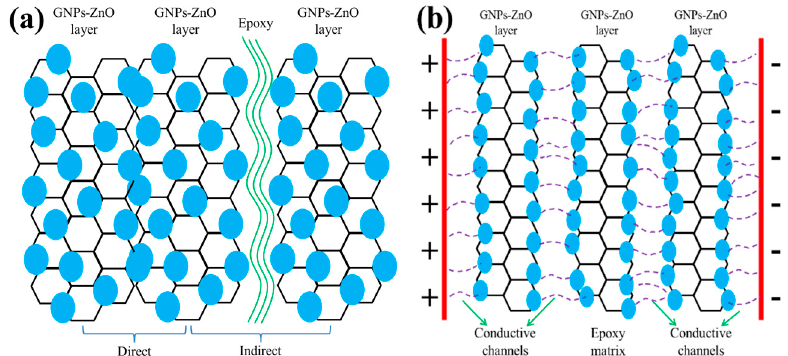
Figure 10. ( a ) Schematic of GNP-ZnO hybrids in composites, ( b ) illustration of the GNP-ZnO / ER structure under a high applied voltage